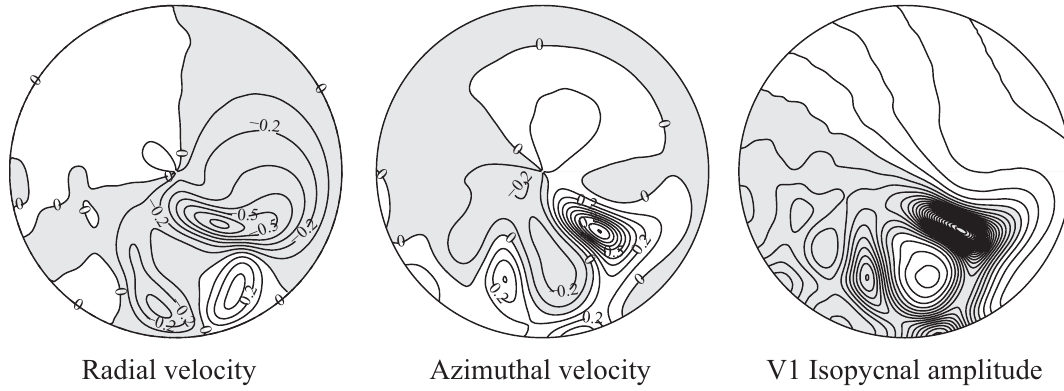
Fig. 12. : Instantaneous velocity components at the upper surface of the lake for B = 2, W = 1 . 2 at t = 3 T i along with the corresponding isopycnal amplitude of the first vertical mode taken from Fig. 11. Contour level step is every 0.1 dimensionless unit, and shaded regions represent negative values. ( h 2 = 1, h 3 =